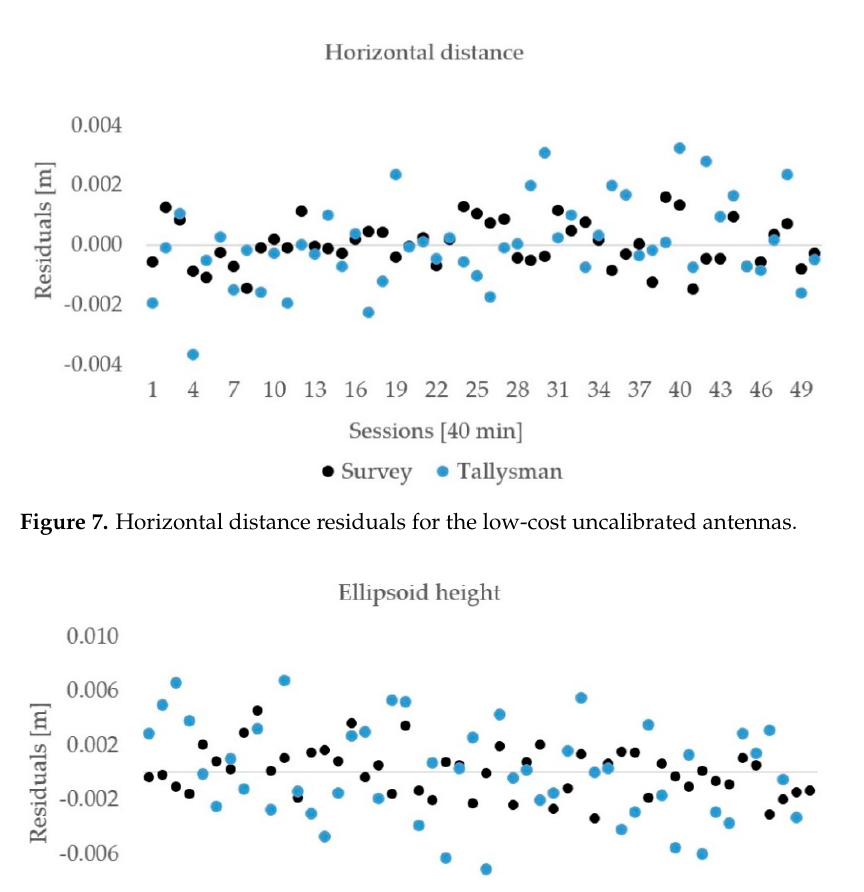
Table 5. Ellipsoid height statistics for the low-cost uncalibrated antennas.